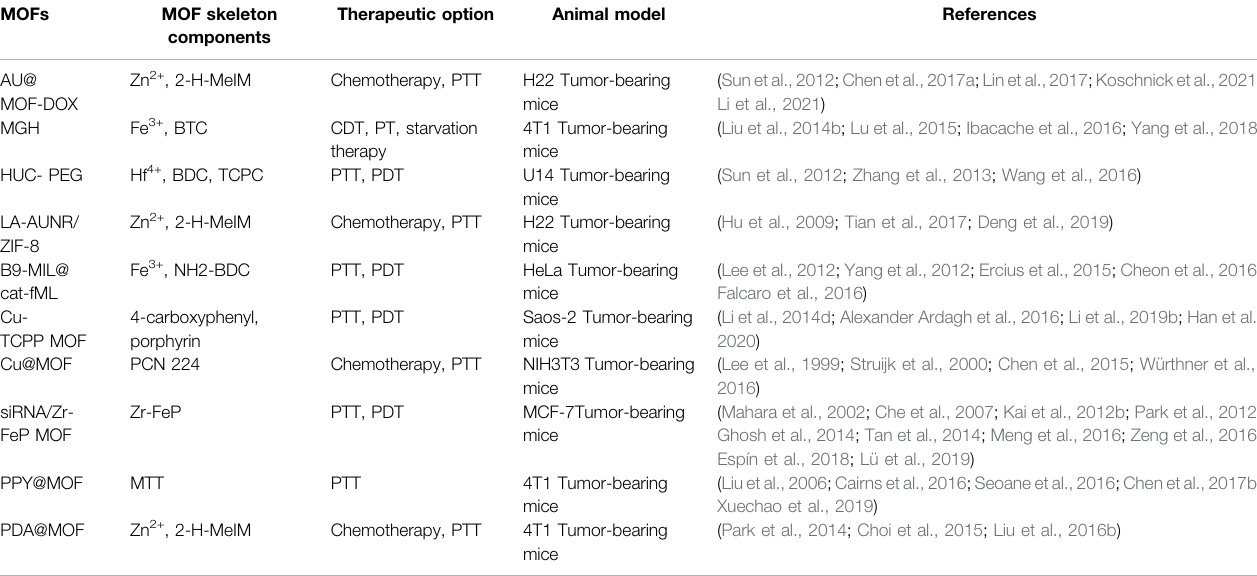
TABLE 1 | Summary of MOFs used as photothermal theranostic platforms